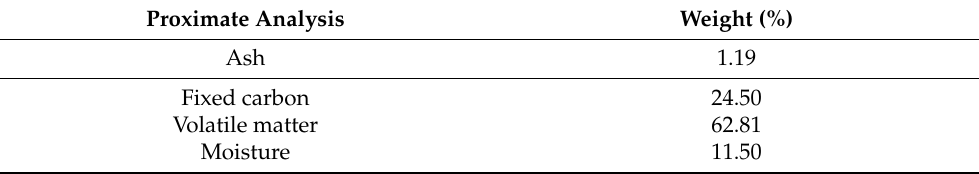
Table 1. Proximate analysis of Stipa tenacissima leaves (STLs).